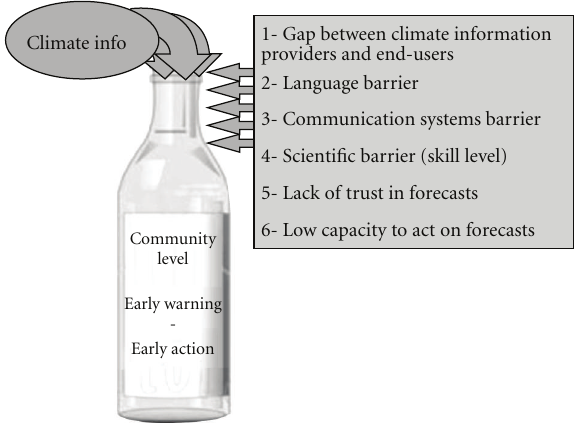
Figure 1: The bottlenecks to climate information access and use by vulnerable communities in West Africa (source: